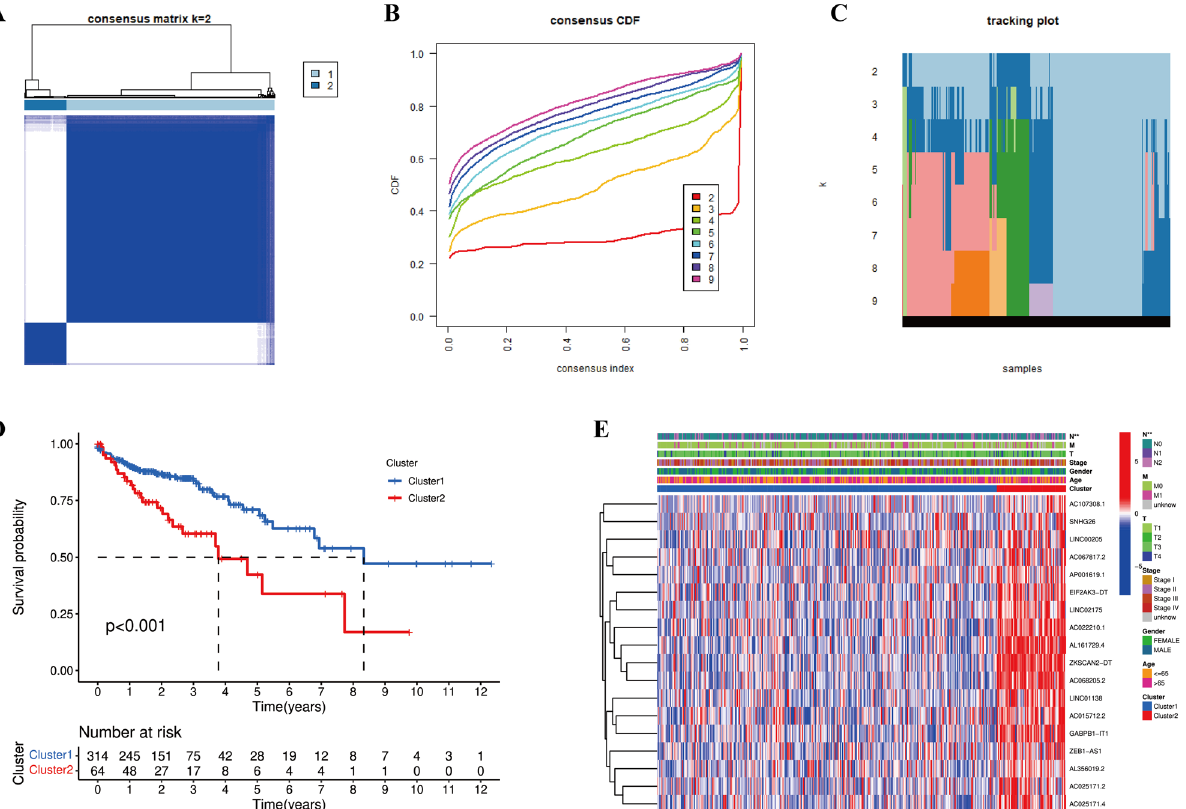
Figure 4. Correlation between cluster subtypes and clinical characteristics in COAD samples. ( A – C ) k = 2 as the optimal clustering parameter in consensus clustering analysis. ( D ) Kaplan–Meier curves of overall survival (OS) in different clusters. ( E ) Correlation analysis between cluster subtypes and clinicopathological features. ** p <